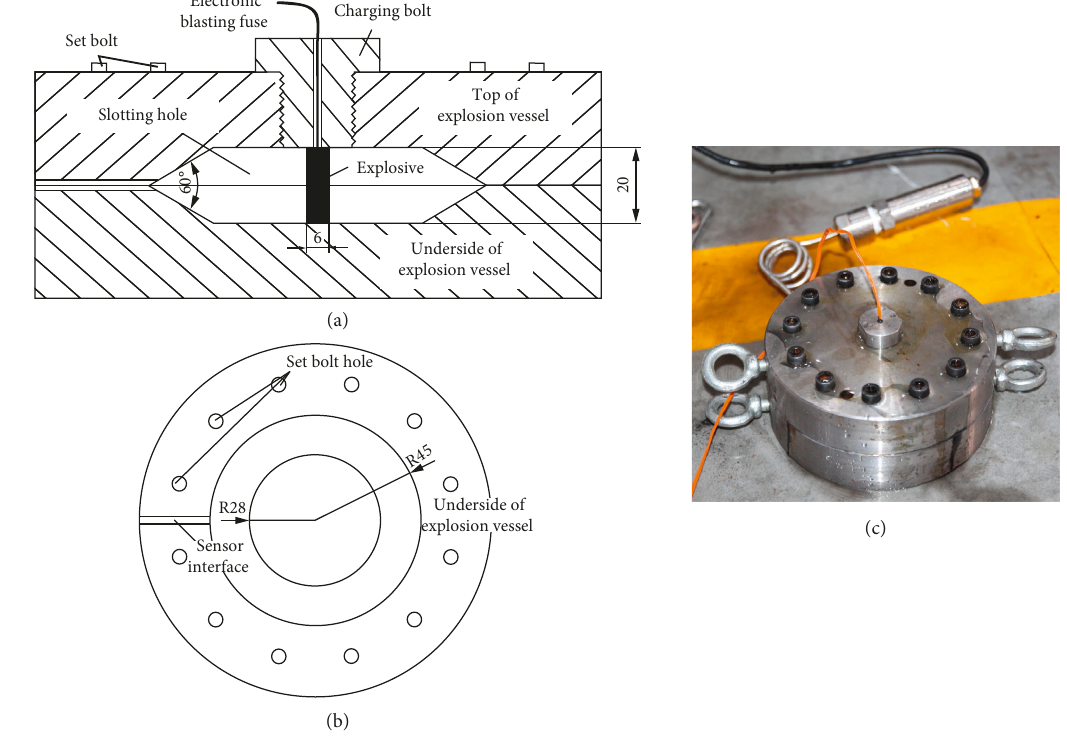
Figure 4: Slotting explosive chamber: (a) sectional view; (b) top view of underside; (c) photograph.